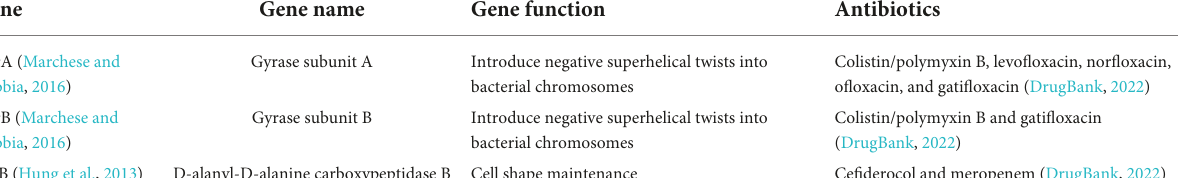
TABLE 2 Gene name, function, and antibiotic which target respected genes.